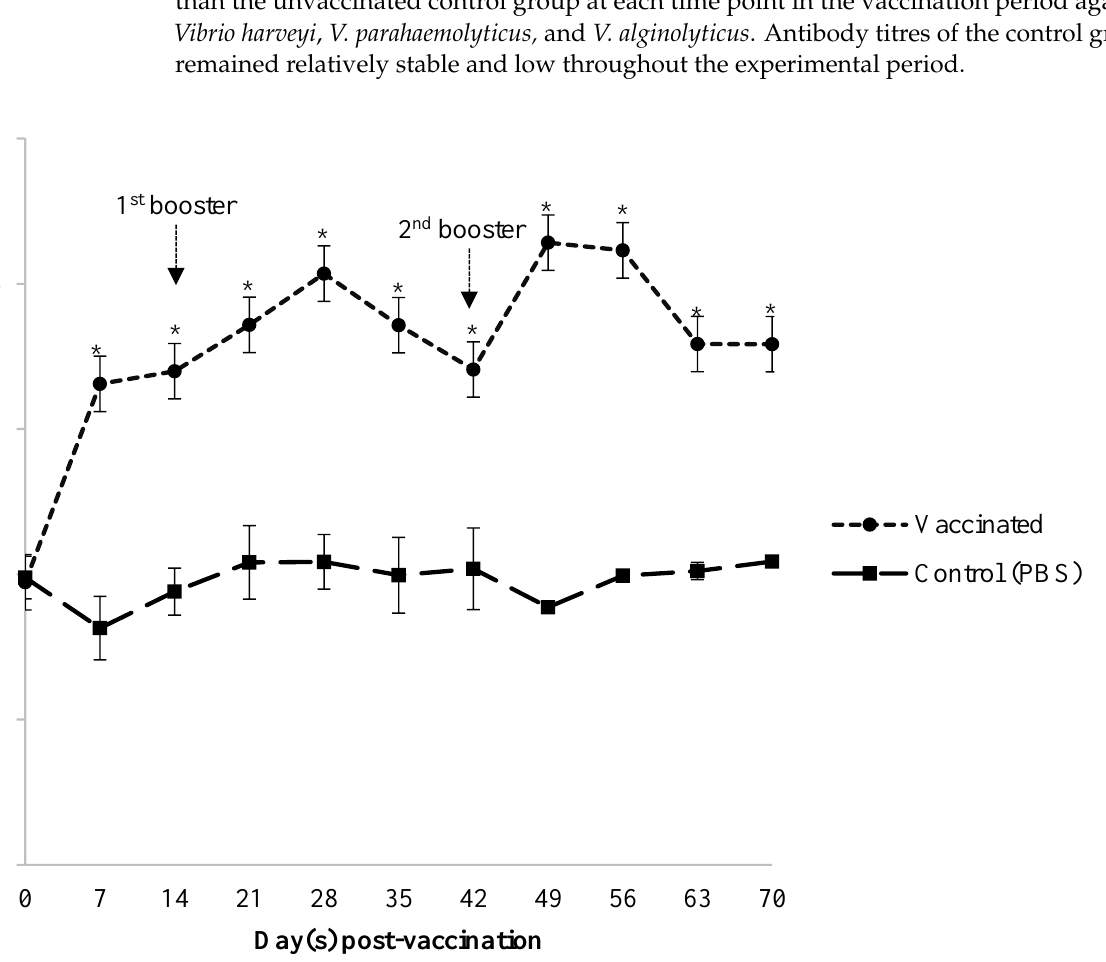
Figure 2. Antibody level of specific IgM in serum against Vibrio harveyi strain VH1 in Asian seabass, Lates calcarifer following oral vaccination with Vibrio harveyi strain VH1. Data are the mean ± SD from 6 fish per group at each time point. Asterisks stand for statistically significant differences ( p < 0.05) between groups.